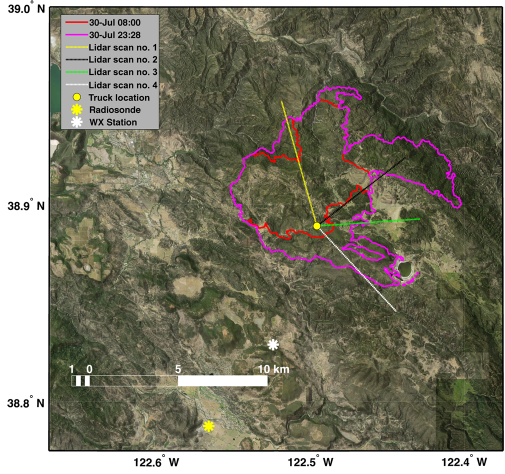
Figure 10. Rocky Fire progression map for 30 July 2015. The fire perimeters are from the US National Forest Service National In- frared Operations (NIROPS) flights. The background is a satellite image draped over the terrain, which is indicated with hill shad- ing. Also shown are the truck location (yellow dot), lidar scan paths (colored lines), radiosonde location (yellow star), and weather sta- tion location (white